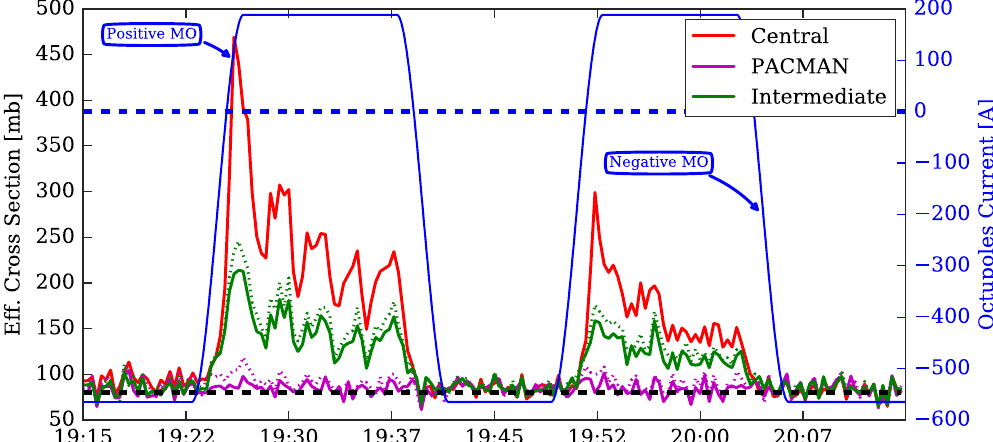
FIG. 6. 2017 ATS MD: lifetime evolution for various individual bunches of Beam 1 when scanning the MO current in collision at β (cid:1) ¼ 35 cm ( r Tele ≈ 3 ), with an aggressive crossing angle of 240 μ rad (full). During the scan, the average bunch population of Beam 2 Tele was measured in between 1 . 0 × 10 11 and 0 . 95 × 10 11 p = b. The lifetime is expressed in terms of so-called effective cross-section, i.e., ¼ def j dN =dt j = L loss rate normalised by luminosity, σ i i . Pacman and intermediate bunches were selected to experience only half or three eff i quarters of the BBLR encounters (two bunches for each case, in dashed and solid lines, located at the head and at the tail of the first bunch train), compared to the central bunch (solid red line) undergoing the maximum possible number of BBLR collisions. Reverting the MO polarity, the burn-off limit of 80 mb (total inelastic proton cross-section at 6.5 TeV) was reached for all classes of bunches.